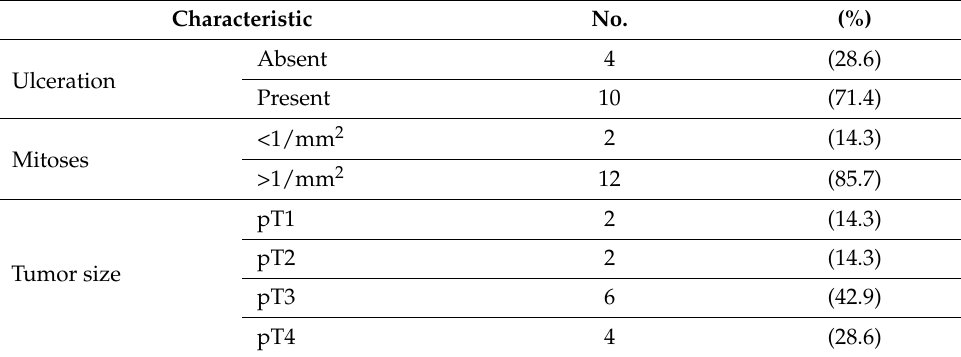
Table 2. Tumor pathologic characteristics of primary melanomas. The considered features of primary melanomas ( n = 14) were tumor size, ulceration and